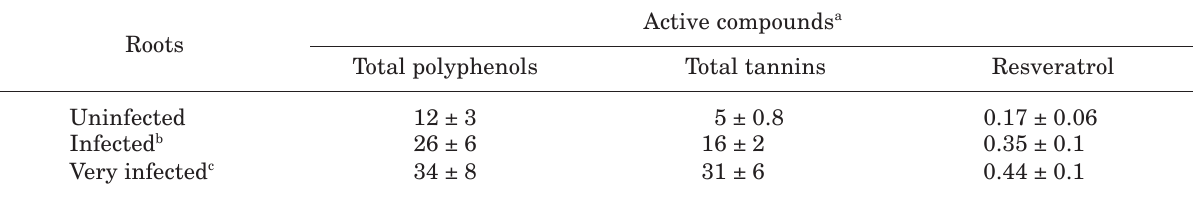
Table 1. Concentration of total polyphenols (gallic acid g/100 g f wt), total tannins (condensed and hydrolysable, expressed as catechin equivalents g/100 g f wt and gallic acid g/100 g f wt respectively), and resveratrol (g/100 g f wt) in roots with different percentages of blocked/discoloured xylem.